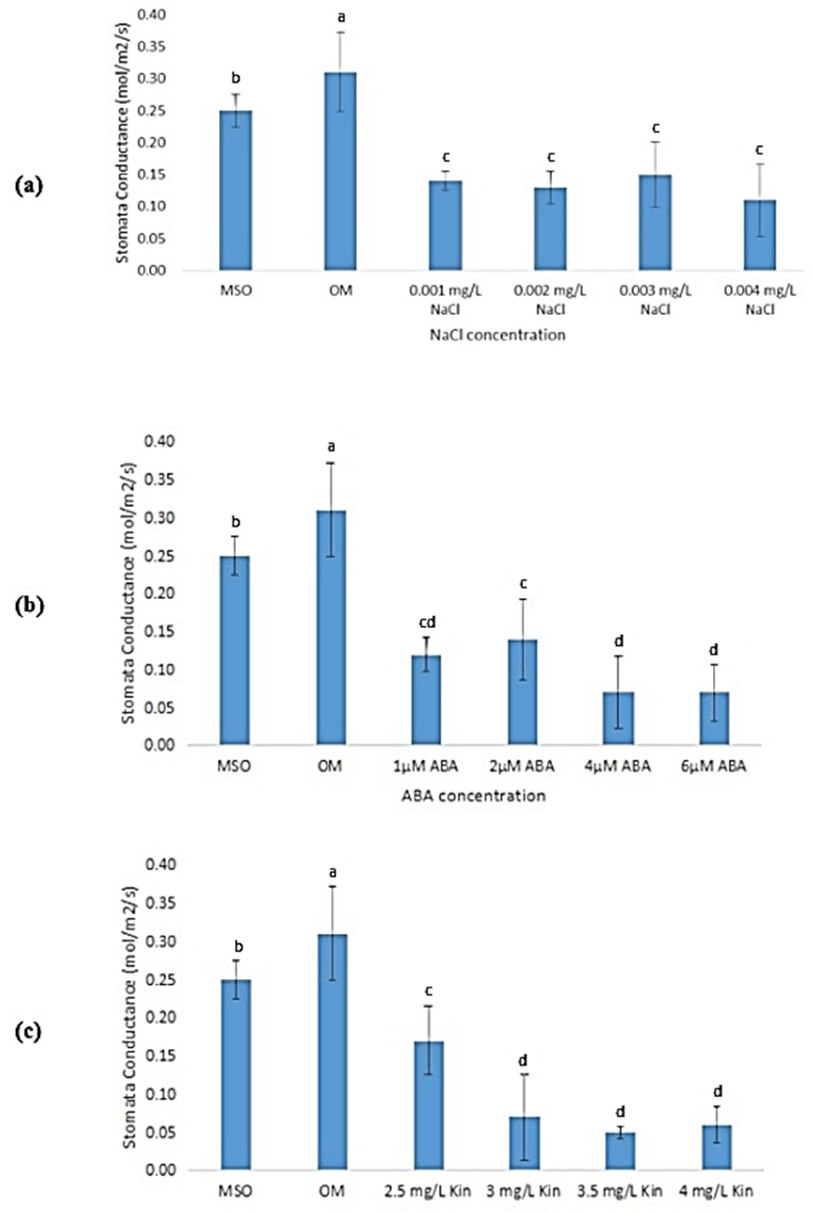
Figure 12. Stomatal conductance of plants exposed to: ( a ) salt stress; ( b ) ABA; ( c ) high kinetin levels. Means with different letters are significantly different at p < 0.05 according to Duncan’s multiple range test (DMRT).